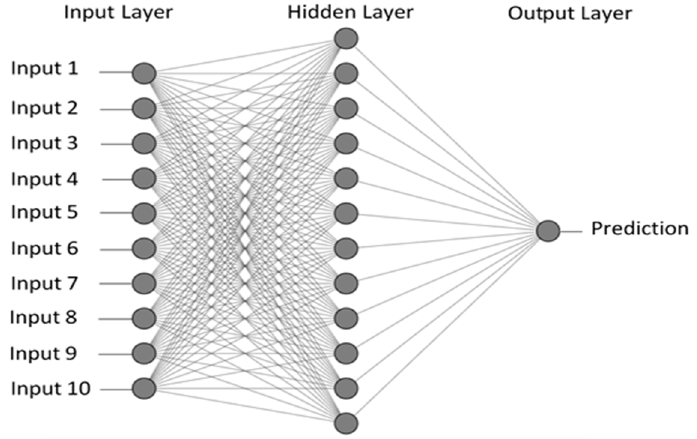
Figure 1. Structure of ELM model.